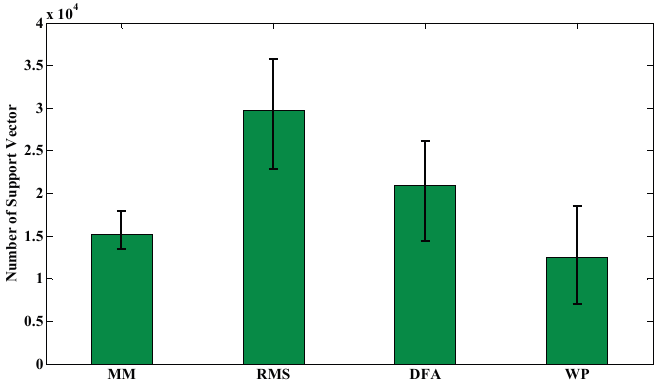
Figure 6. Number of support vectors for different feature extraction